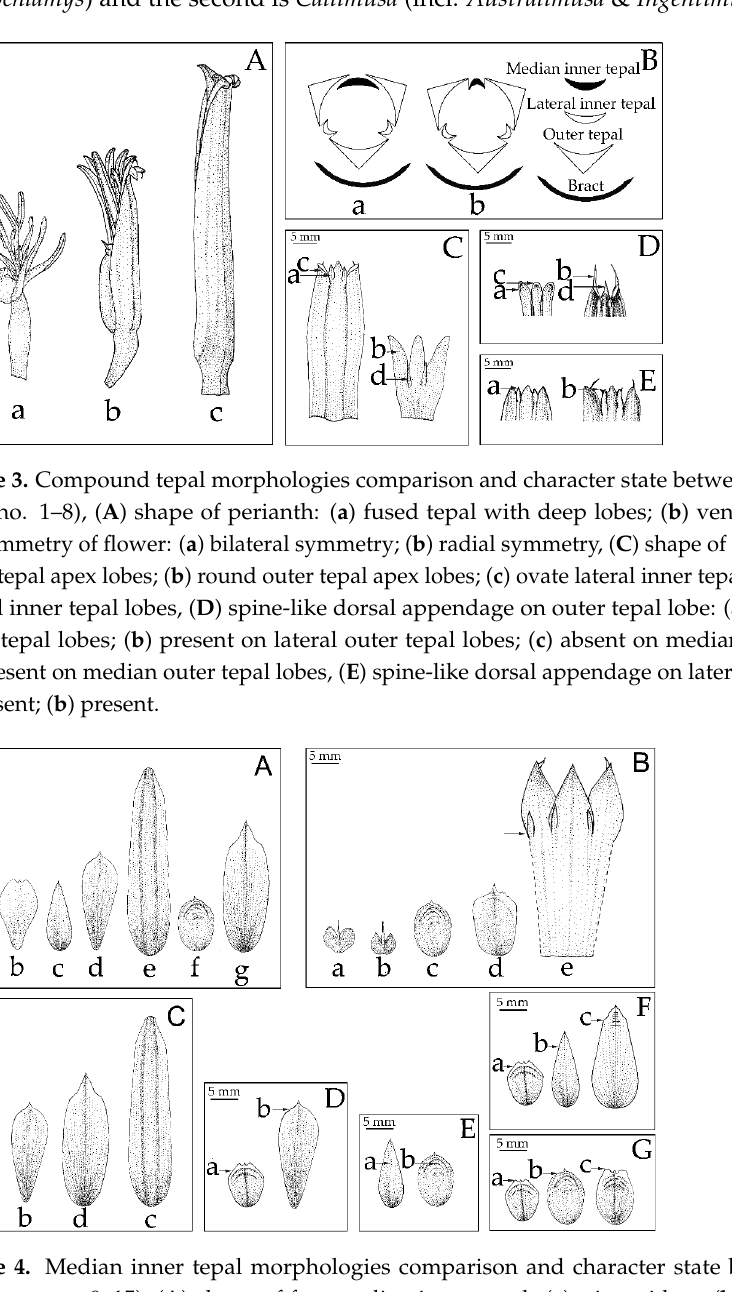
Figure 10. Stamen and pistil morphologies comparison and character state between Musaceae (char- acter no. 17–21), ( A ): shape of anther: ( a ) oblong; ( b ) ensiform, ( B ) shape of stigma: ( a ) capitate; ( b ) clavate; ( c ) spatulate, ( C ) wart-like structure present on style surface: ( a ) absent; ( b ) present, ( D )shape: ( a ) cylindrical; ( b ) angular. 4.6. Character Evolution and Analysis Using fresh flowers, dried specimens or pictures from original publication, five qual- itative characters of male flowers including perianth symmetry (bilateral, radial and asymmetric), lateral inner tepal shape (acicular and ovate), median inner tepal shape (tri- cuspidate, obovate, oval-lanceolate, oblanceolate, oblong, elliptic, ovate and fused with perianth tube), stigma shape (clavate, spatulate and capitate) and style length (shorter than 18 mm and longer than 18 mm) were investigated (Table S1). The data matrix was coded into binary or multistate variables with unordered states. The species of which spec- imens cannot be observed were treated as a missing data. Evolution of the floral characters